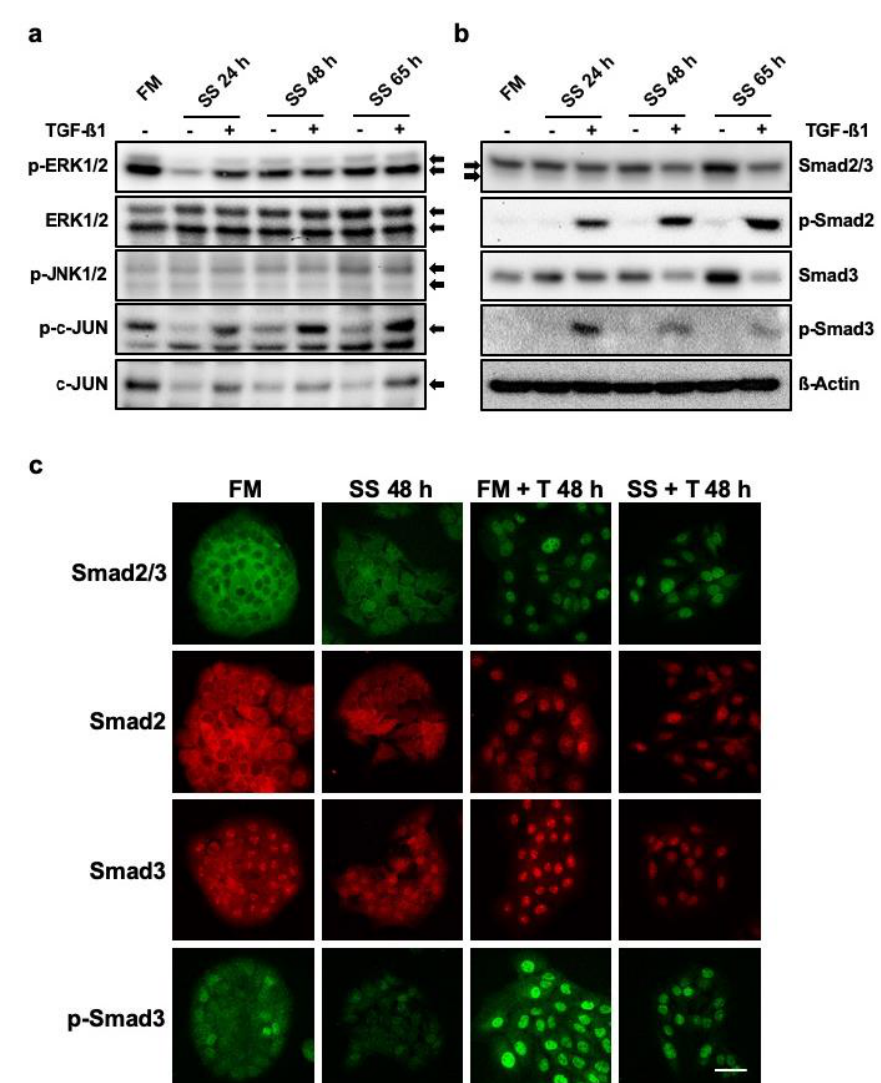
Figure 4. Continued exposure to TGF- β 1 in HaCaT cells affects the expression of proteins involved in its transduction pathway. The expression and activation status of the indicated proteins involved in either canonical; ( a ) or non-canonical ( b ) TGF- β pathways were assessed by means of Western Blot. Normalized total protein extracts from HaCaT cells cultured for the indicated times in SS conditions, with, or without, TGF- β 1, were compared with control samples from cells growing in FM. β -Actin was used as protein loading control. Arrows indicate the correct identity of protein bands. p-: phosphorylated protein form. ( c ) Changes in the protein expression and localization of receptor regulated Smads in response to continued TGF- β 1 exposure. Representative confocal microscopy images of at least three independent experiments are shown. Scale bar: 50 µm. FM: full medium; SS: serum starvation; + T48: time (hours) of continuous TGF- β 1 exposure.